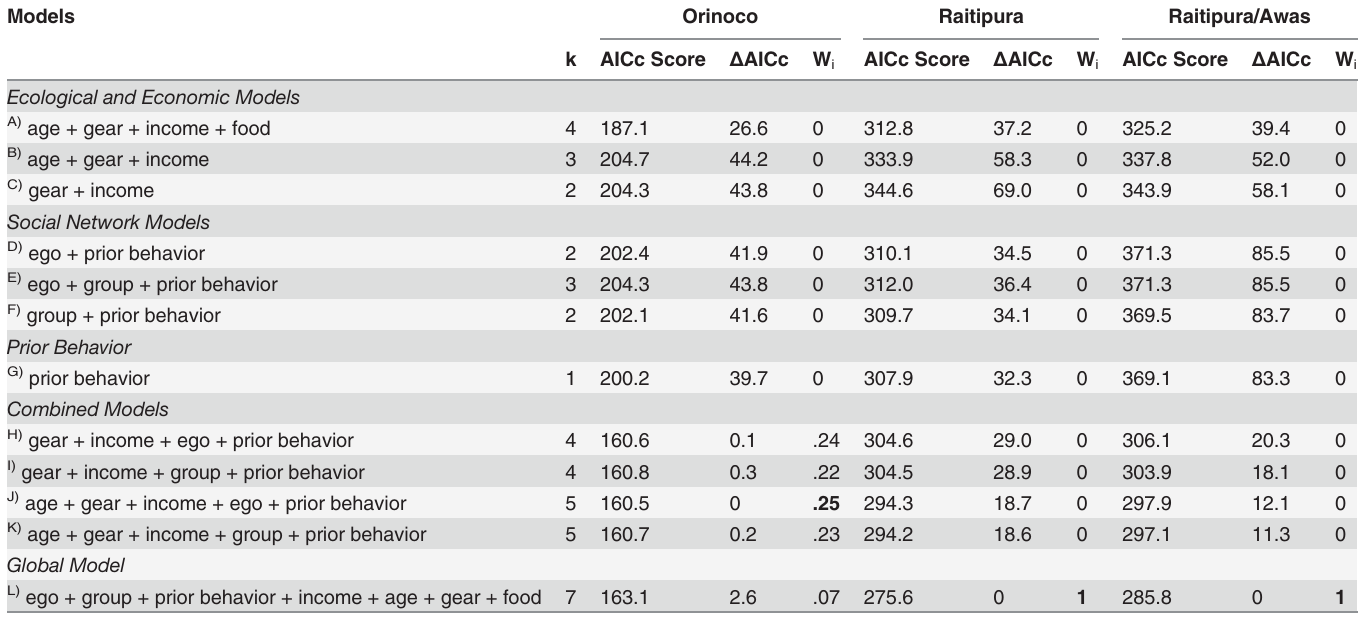
1 See S1 Table for parameter estimates and adjusted r-squared for models of best fi